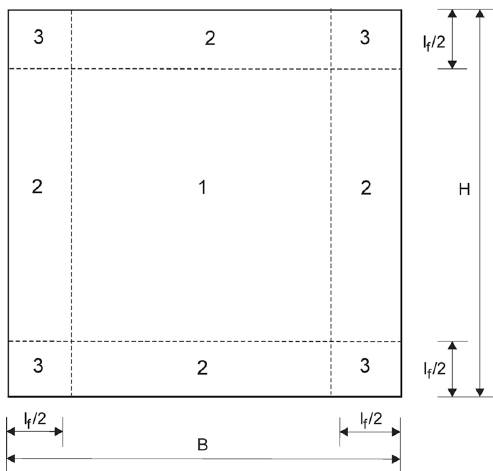
Fig. 5. Composite space cross-section divided into sections (2): l f – fibre length; H –element height; B – element